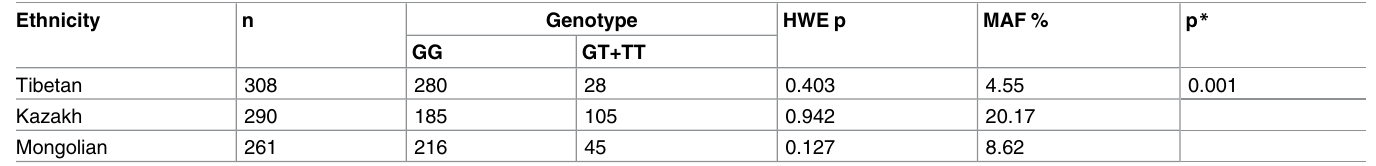
Table 2. Occurrenceof genotype and allele frequencies of the PRL rs1341239polymorphism in three ethnical subjects.